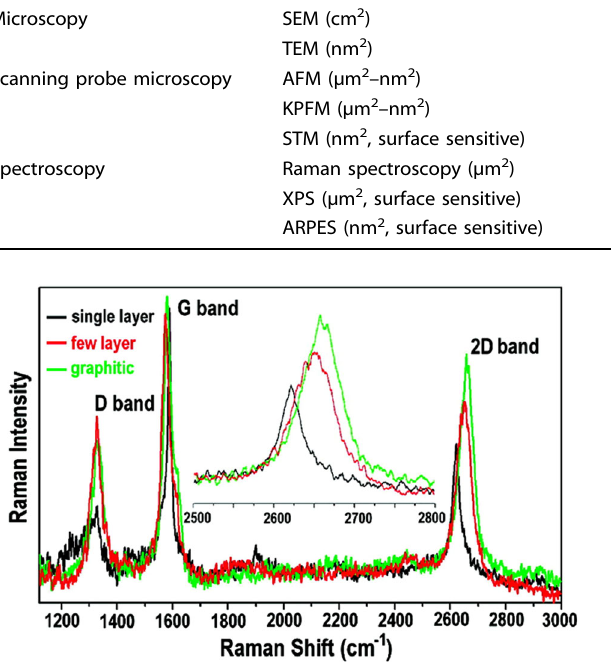
Fig. 3 Raman spectroscopy results. Raman spectra of NDG with different numbers of layers. The inset is a zoomed-in view of the 2D band (reproduced from 56 with permission from the American Chemical